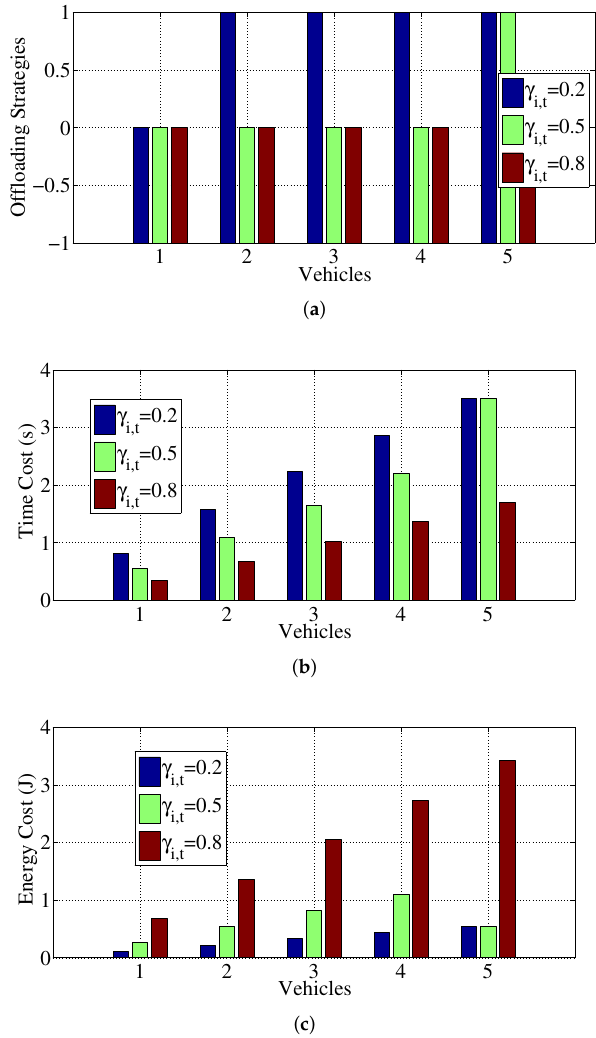
Figure 2. Impacts of the values of weighting factors. ( a ) Offloading strategies; ( b ) time cost; ( c ) energy cost.